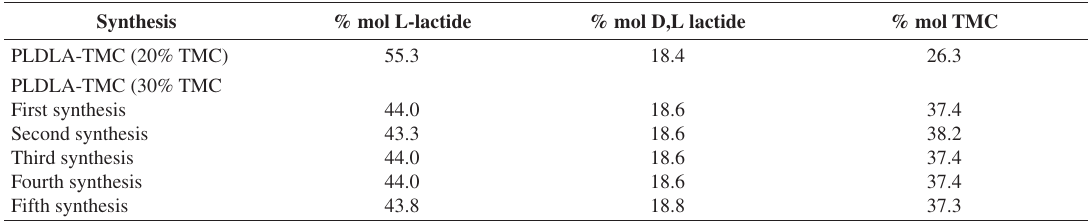
Table 1. Data on terpolymer l-lactide, D,L lactide and TMC synthesized by polymerization in bulk 130 °C, 48 hours.